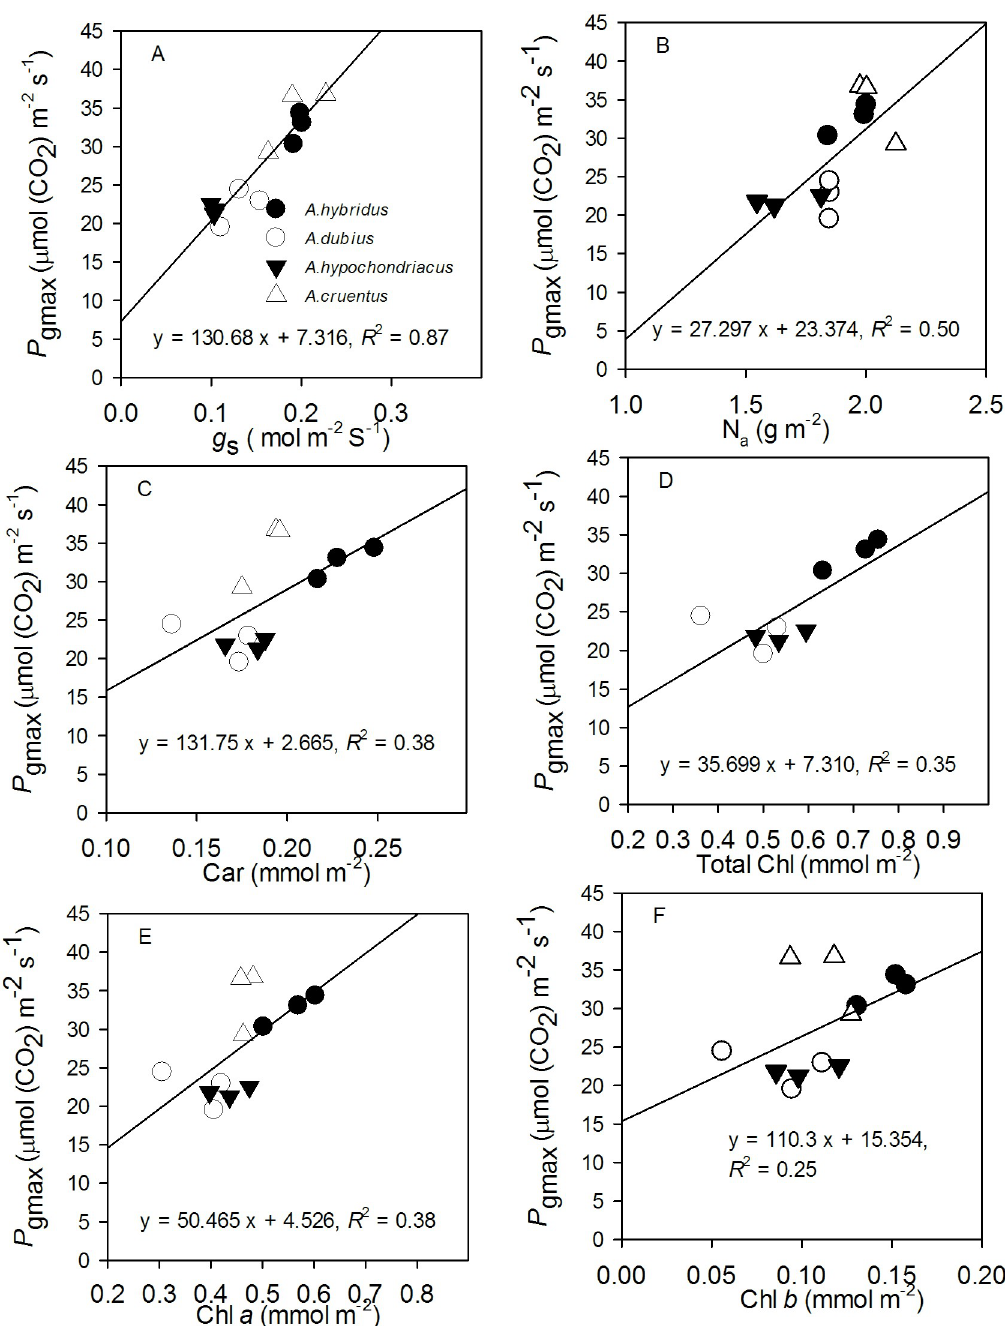
Fig 3. Relationship between leaf traits and maximum gross photosynthetic rate ( P gmax ) for four amaranth species ( A . hybridus , A . dubius , A . hypochondriacus , and A . cruentus ). A – F (stomatal conductance ( g s ) measured at the maximum PPFD of 1500 μ mol (photons) m –2 s –1 , nitrogen per unit area (N a ), carotenoids (Car), Chlorophyll (Chl a , total Chl, Chl b ). The three data points for each species represent the means of the variables at the three measurement dates (50, 55, and 63 days after sowing). Measurement conditions for the gas exchange measurements were leaf temperature of 25˚C, CO 2 concentration of 400 μ mol mol -1 , average relative humidity of 60–70%, and a vapour pressure deficit of 1.3 ± 0.3 kPa.